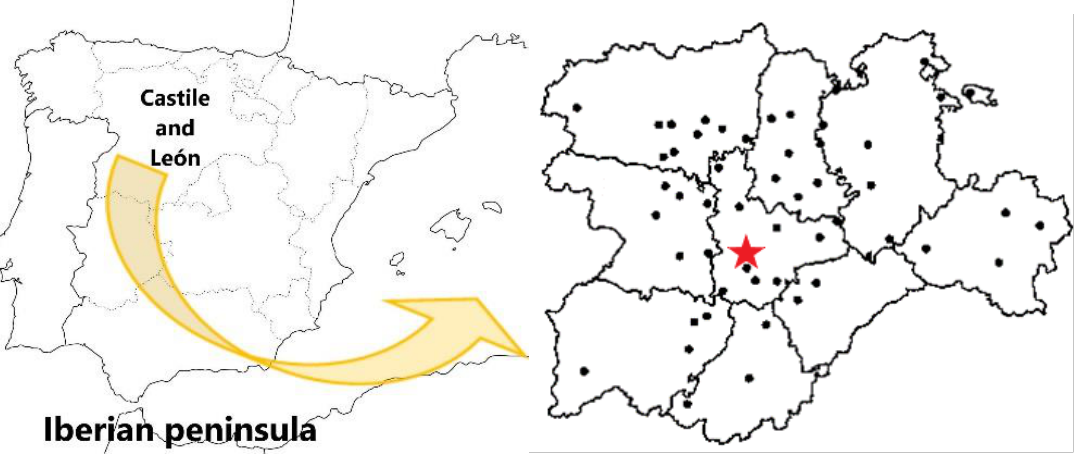
Figure 1. Location of the 54 agrometeorological stations belonging to the Agro-climatic Information System for Irrigation (SIAR) located in Castilla and León Region, Spain [32], highlighting (red star) the site of the agrometeorological station referenced for this study (Tordesillas, Valladolid).